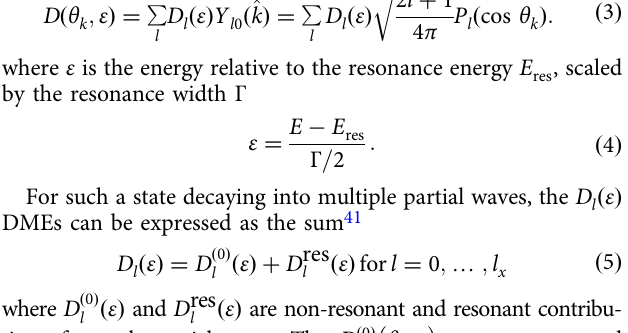
Fig. 2 in the region of the 4 σ ! k σ (cid:4) shape resonance can be interpreted based on a Fano line-shape analysis 38 as applied to